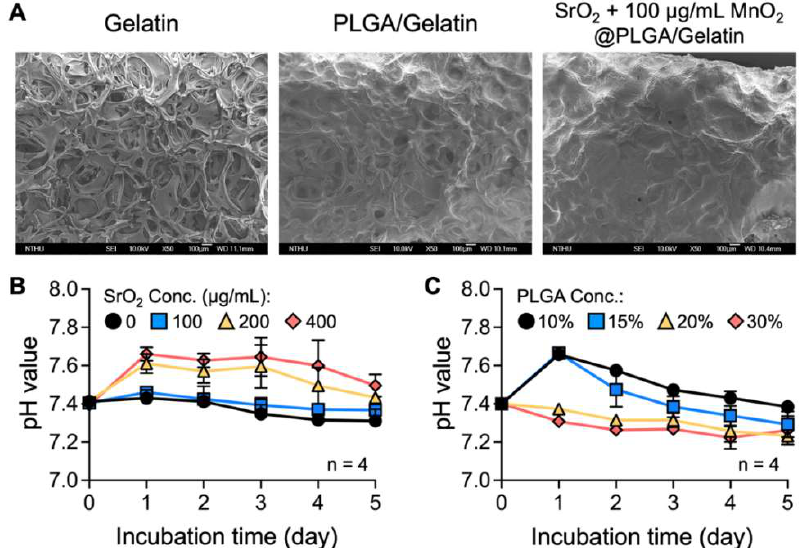
Figure 1. Fabrication and optimization of the SrO 2 + MnO 2 @PLGA/gelatin scaffolds. ( A ) SEM images of the surface of the gelatin sponge and the prepared scaffolds. ( B , C ) The pH values of phosphate-buffered saline (PBS) following incubation with the developed scaffolds prepared with various parameters ( n = 4). Data are the mean ±